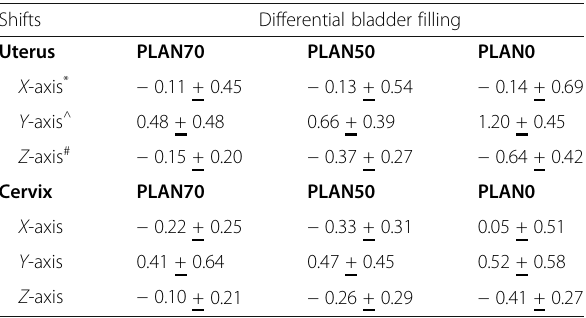
Table 4 Shifts in the center of mass (COM) of utero-cervical axis with variable bladder